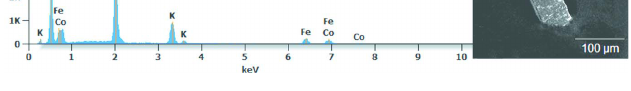
Figure 4 ( a ) EDS spectrum and ( b ) SEM micrographs of the title